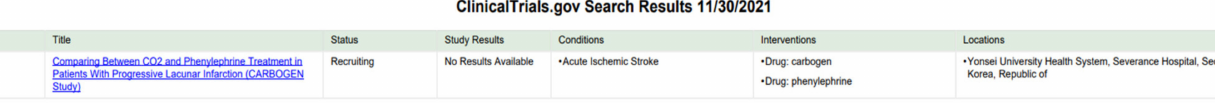
Figure 8. Clinical trials for Therapeutic Gases interventions in acute ischemic stroke on https: //clinicaltrials.gov (accessed on 16 December